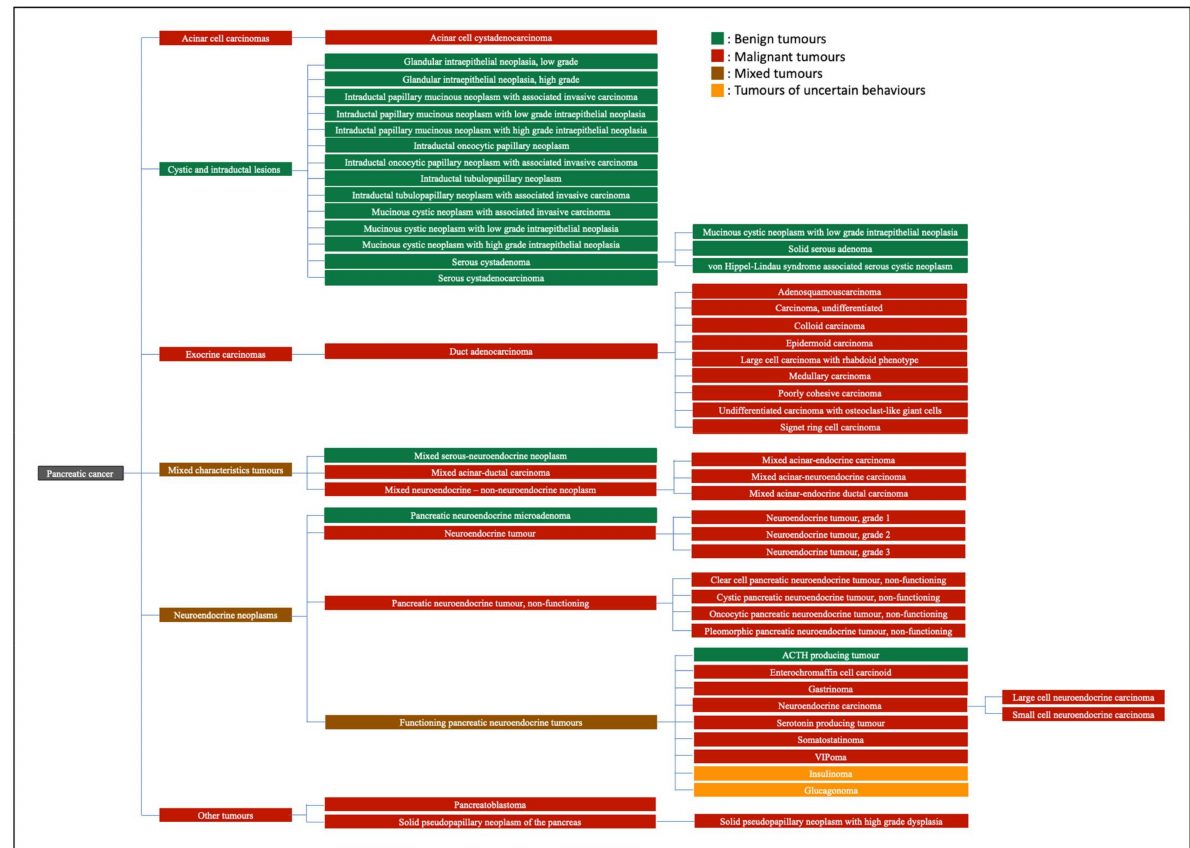
Figure 1. Classification of pancreatic